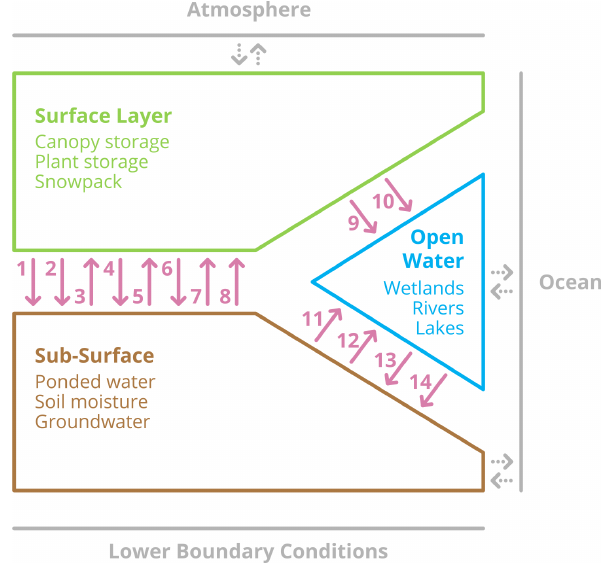
Figure 1. Schematic blueprint of the terrestrial water cycle featuring the three components “Surface Layer”, “Sub-Surface”, and “Open Water”, their transfers of information as numbered arrows (see Ta- ble 1), and their relationships with external models (atmosphere and